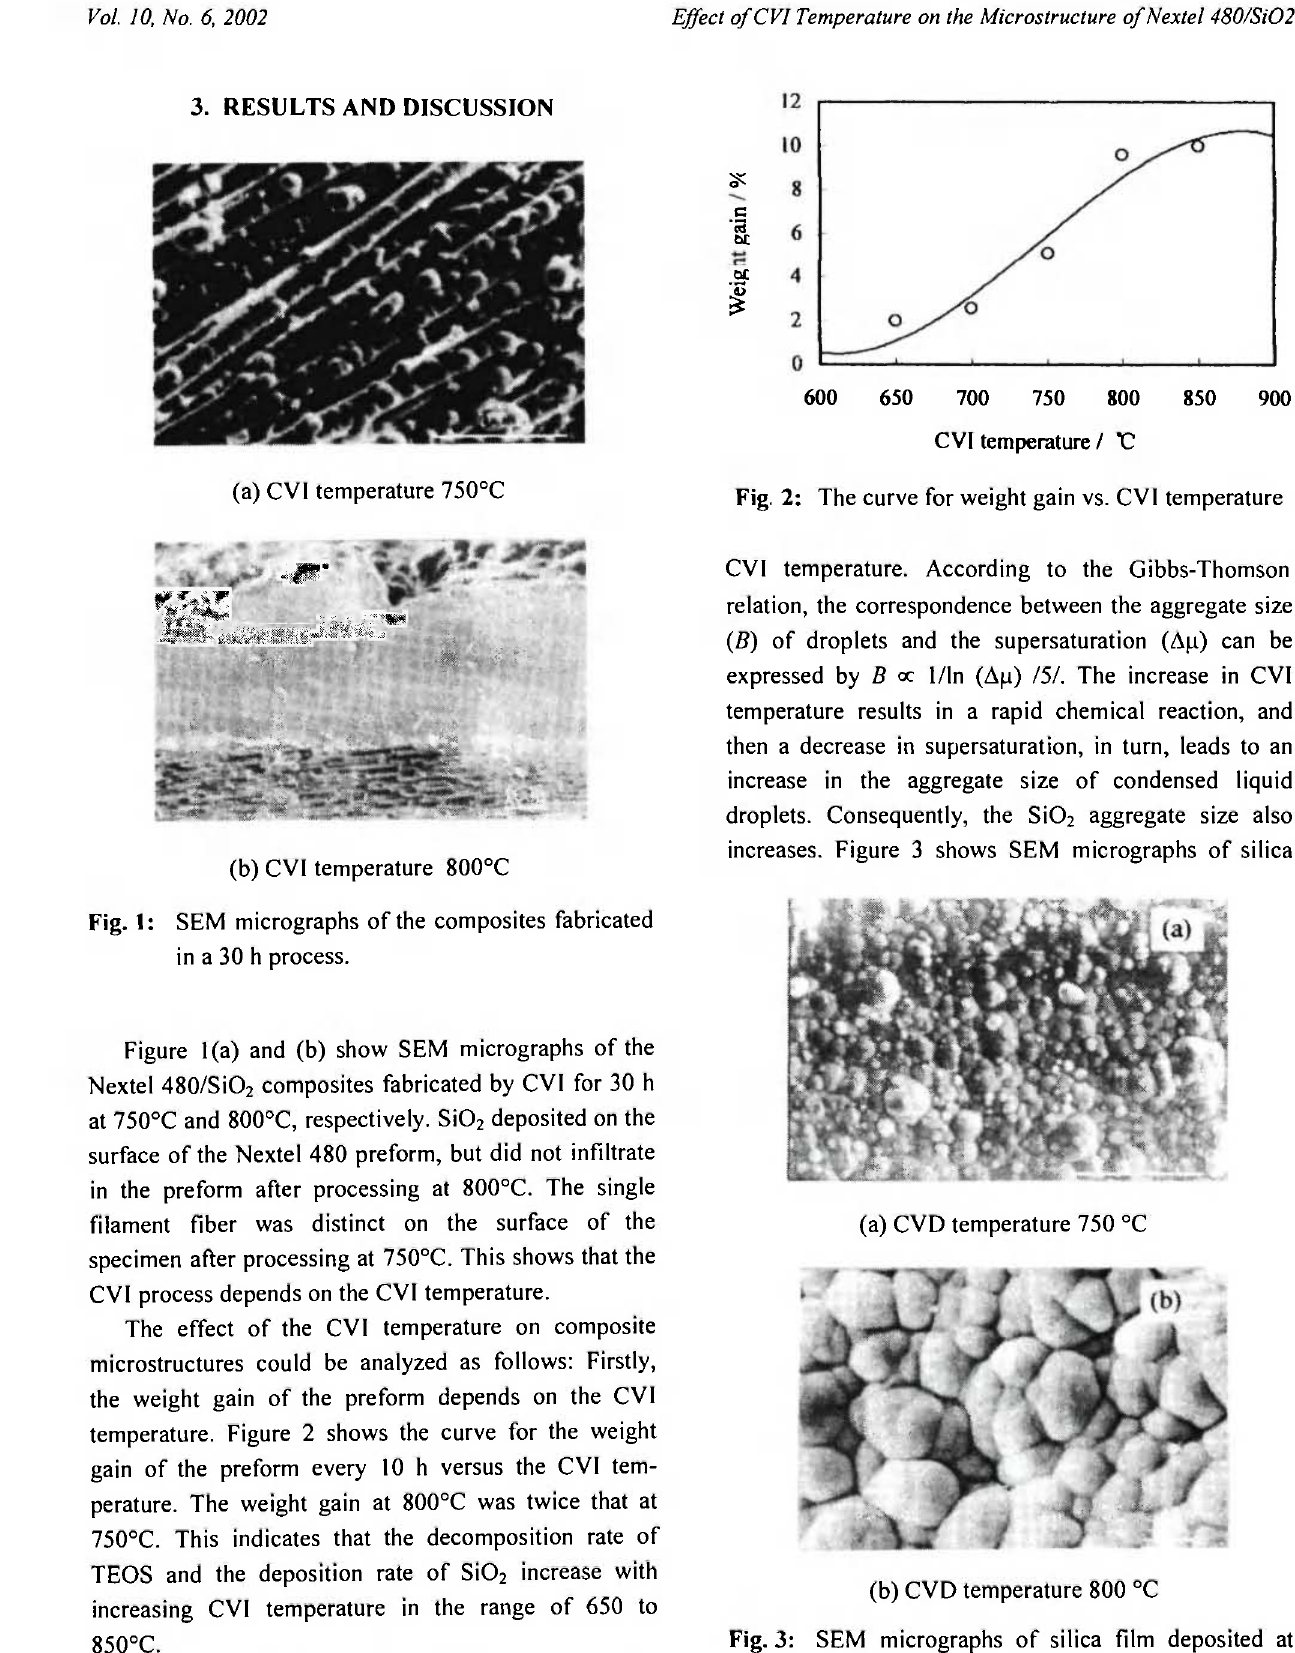
Fig. 3: SEM micrographs of silica film deposited at different